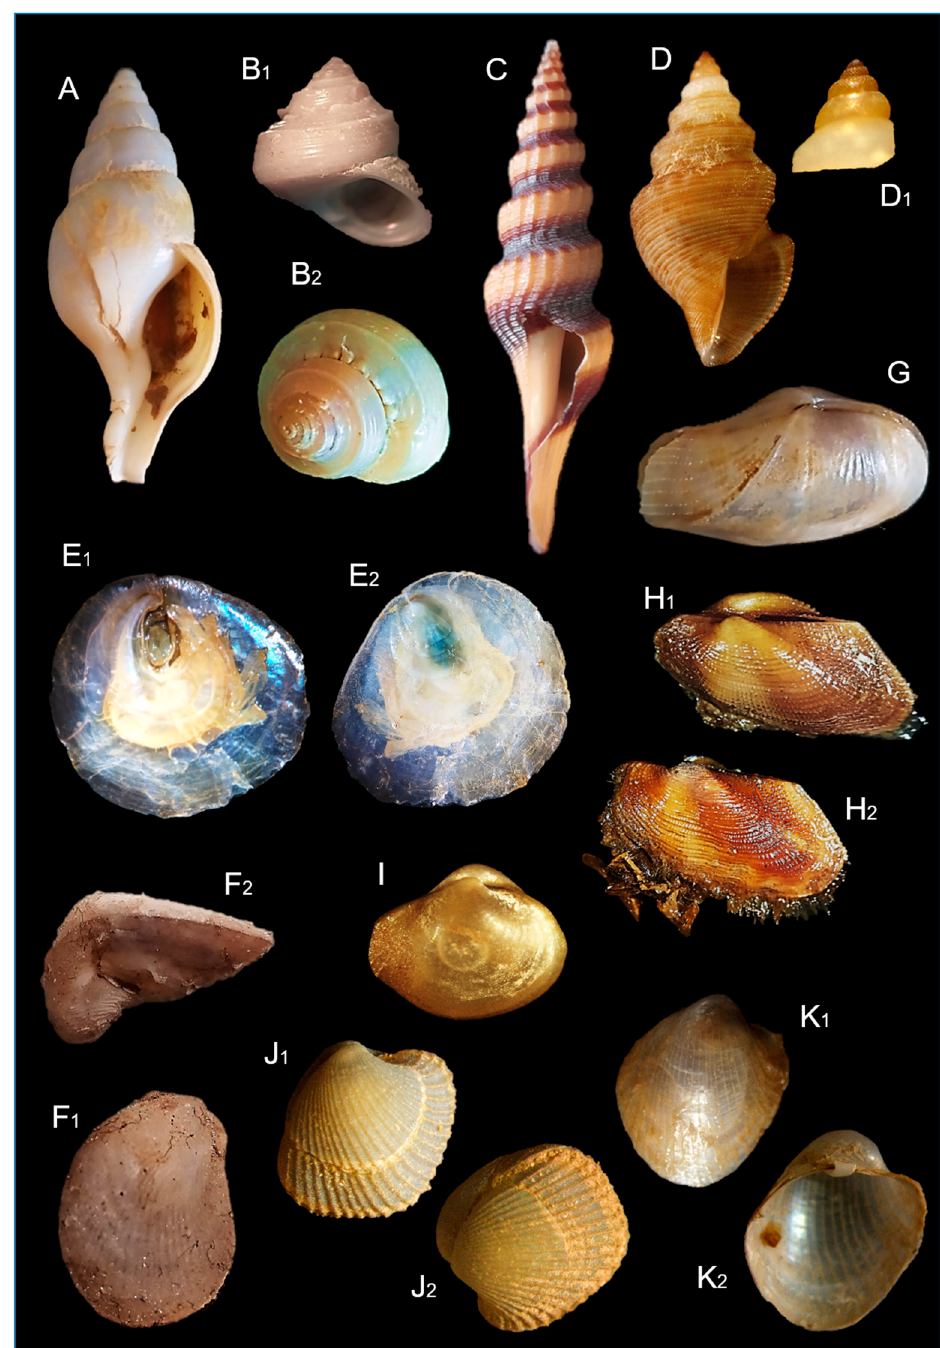
Figure 3. New deep-see molluscans records from Ses Olives, Ausias March and Emile Baudot seamounts in the Mallorca Channel (Balearic Islands): ( A ) Colus jeffreysianus ; ( B 1 , B 2 ) Cantrainea pelori- tana ; ( C ) Fusiturris similis ; ( D , D 1 ) Gymnobela abyssorum; ( E 1 , E 2 ) Pododesmus squama ; ( F 1 , F 2 ) Spondylus gussonii ; ( G ) Allogramma formosa ; ( H 1 , H 2 ) Asperarca nodulosa; ( I ) Cetomya neaeroides ; ( J 1 , J 2 ) Haliris granulata ; and ( K 1 , K 2 ) Policordia gemma . Images not to scale. Distribution: Colus jeffreysianus lives in deep water from 400 to 2100 m from South Iceland and Norway, the Shetland Islands and the Faroes, the Kattegat and SW Skagerrak and off the British Isles. Further southwards it is found on the continental shelf of the Bay of Biscay, the Iberian Peninsula and the western Mediterranean Sea [43]. It is not